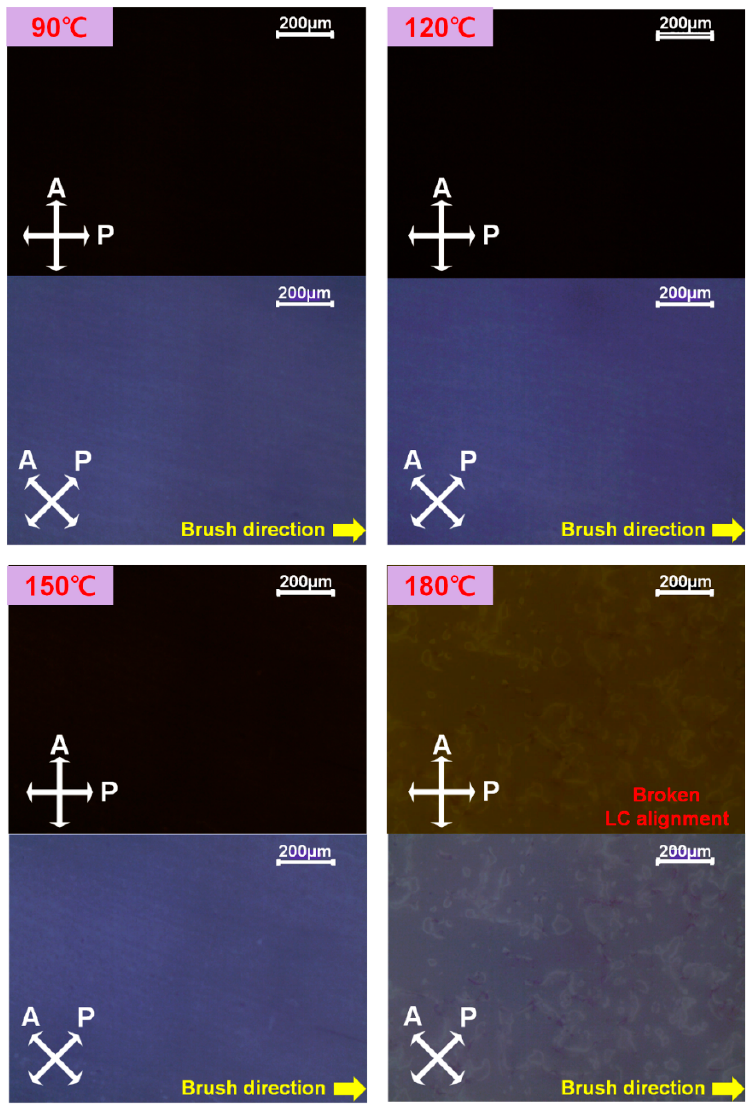
Figure 8. Thermal endurance of the brush-coated nickel yttrium oxide film to uniform LC alignment. Annealing was conducted from 90 to 180 °C at intervals of 30 °C for 10 min at each temperature.